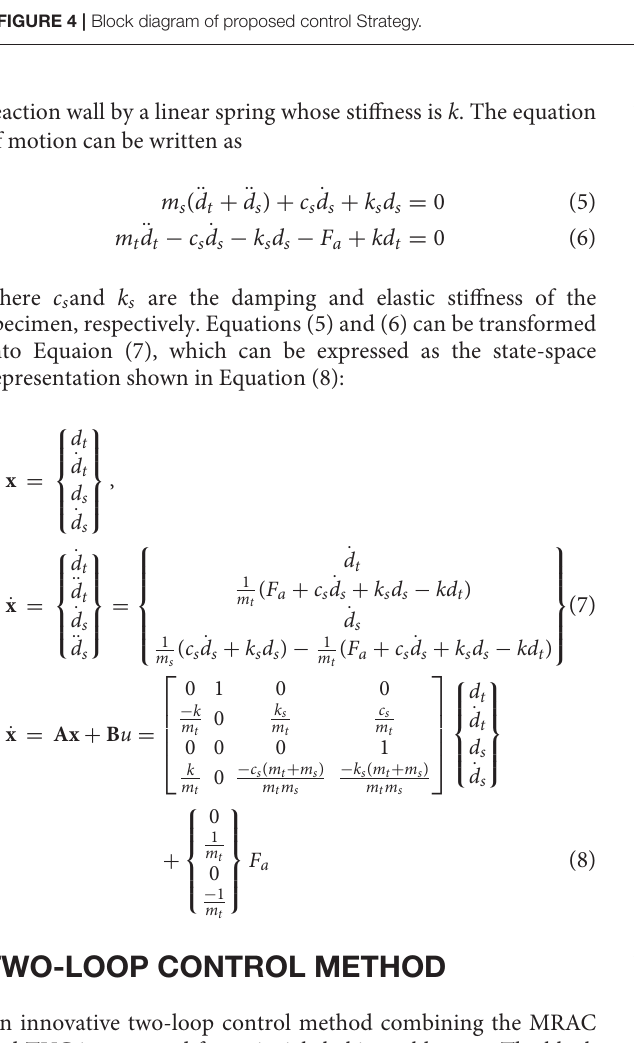
reference model, respectively, K p and K u are the adaptive gains and e x ( t ) is the state